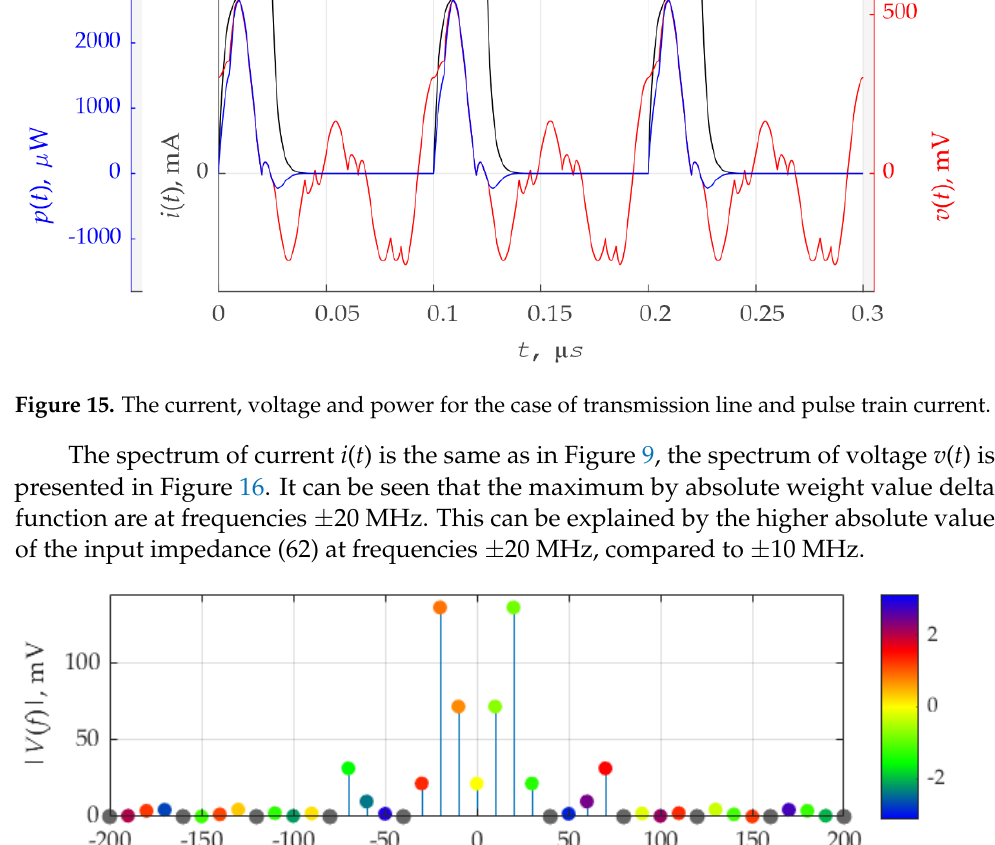
19 of 26 Figure 13. The spectrum of instantaneous power for the case of pulse train current. The following quantitative power characteristics were calculated: the average power (33) P av = 199.4 μW, apparent power (39) P app = 264.7 μVA, power factor (43) PF = 0.75. 3.3. Trasmission Line Example The third example is a lossless transmission line (Figure 14a) with a load, which co- incides with the load of the circuit in Figure 1a. ( a ) ( b ) Figure 14. Transmission line loaded by the resonant circuit ( a ) and the frequency characteristic of its input impedance as impedance module and phase versus the excitation current frequency ( b ). The input impedance of transmission line can be evaluated as [48]: 0 0 22 () c o ss i n ()